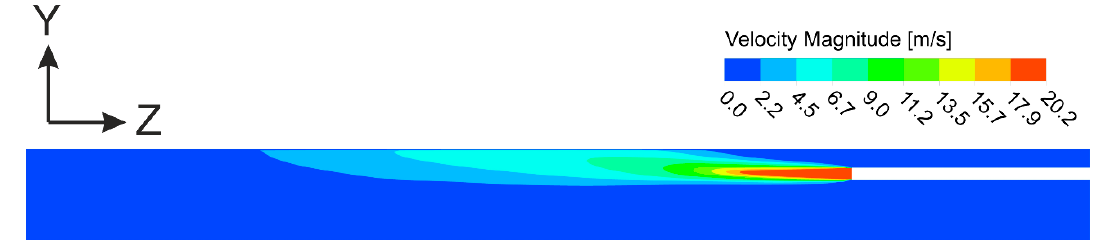
Figure 7. Velocity contours of the air jet exiting the ventilation duct along the tunnel axis. The data correspond to scenario 4 and 20 m/s air velocity at the velocity inlet.